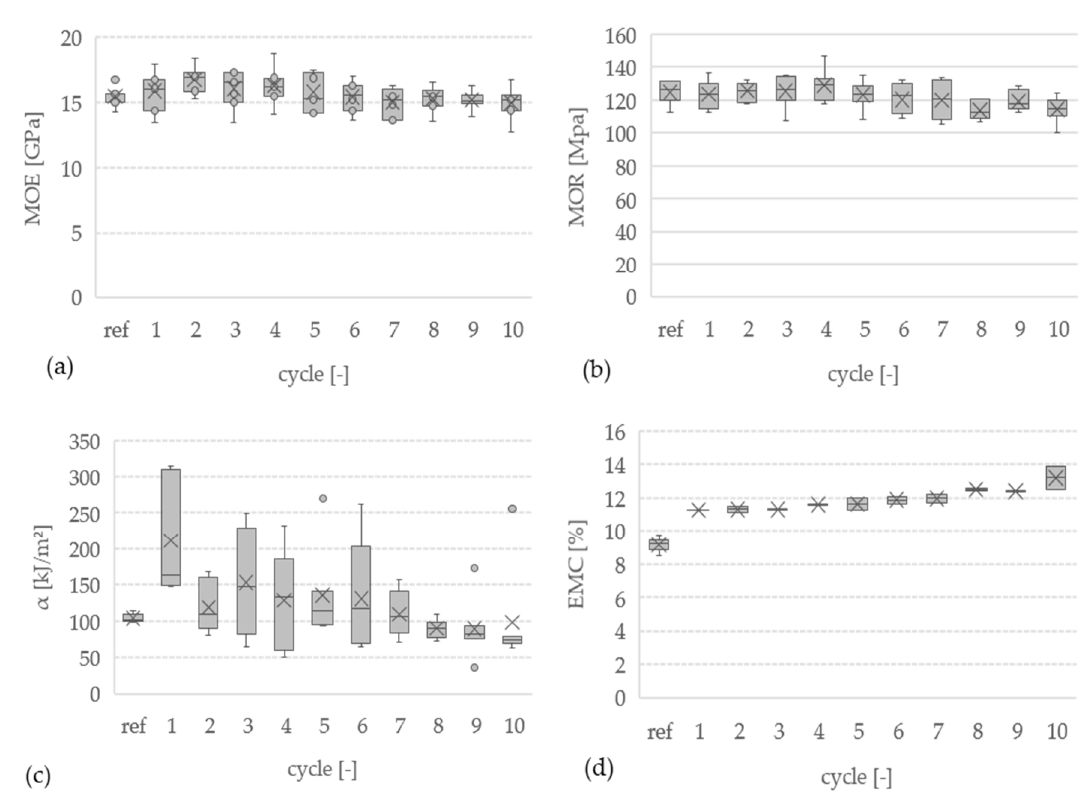
Figure 4. Mechanical and physical properties of artificial weathering for birch solid wood of n = 7 samples. ( a ) bending MOE, ( b ) bending strength, ( c ) impact bending strength and ( d ) equilibrium moisture content. The whiskers present minimum and maximum values, x is the mean value and–is the median.